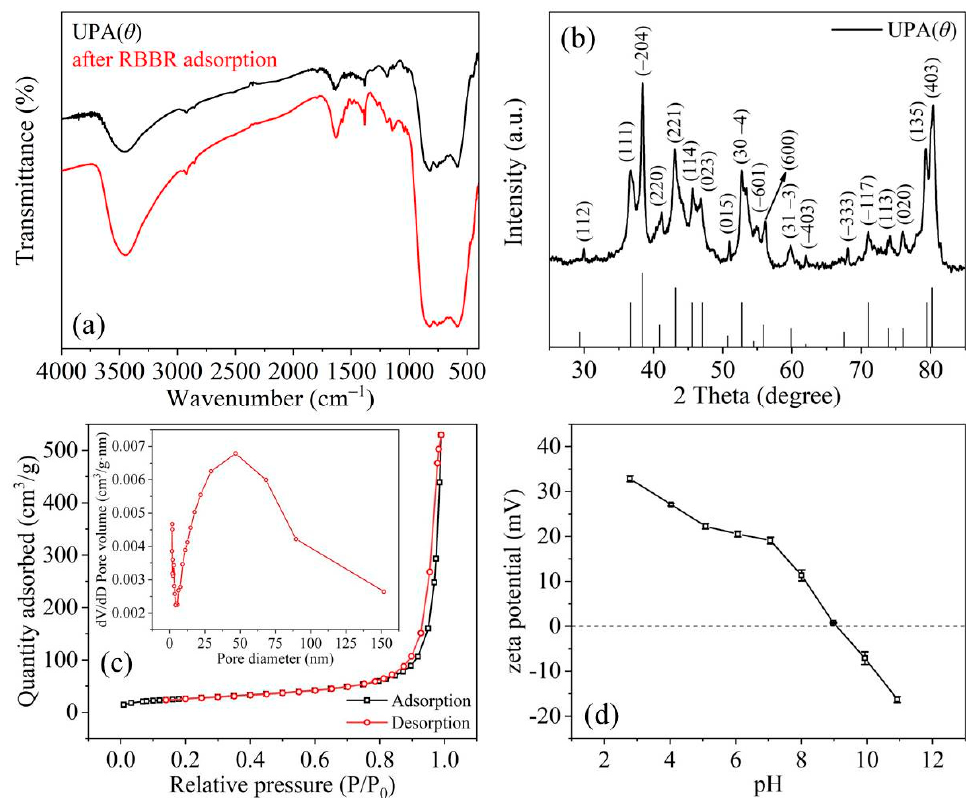
Figure 2. ( a ) FTIR spectra of UPA( θ ) powders before and after RBBR adsorption; ( b ) XRD pattern and ( c ) nitrogen adsorption–desorption isotherm of UPA( θ ) powders (inset: pore size distribution); ( d ) zeta potential value of UPA( θ ) powders as a function of pH. m/V [UPA( θ )] = 4.44 g·L − 1 , I = 100 mmol·L − 1 sodium acetate.